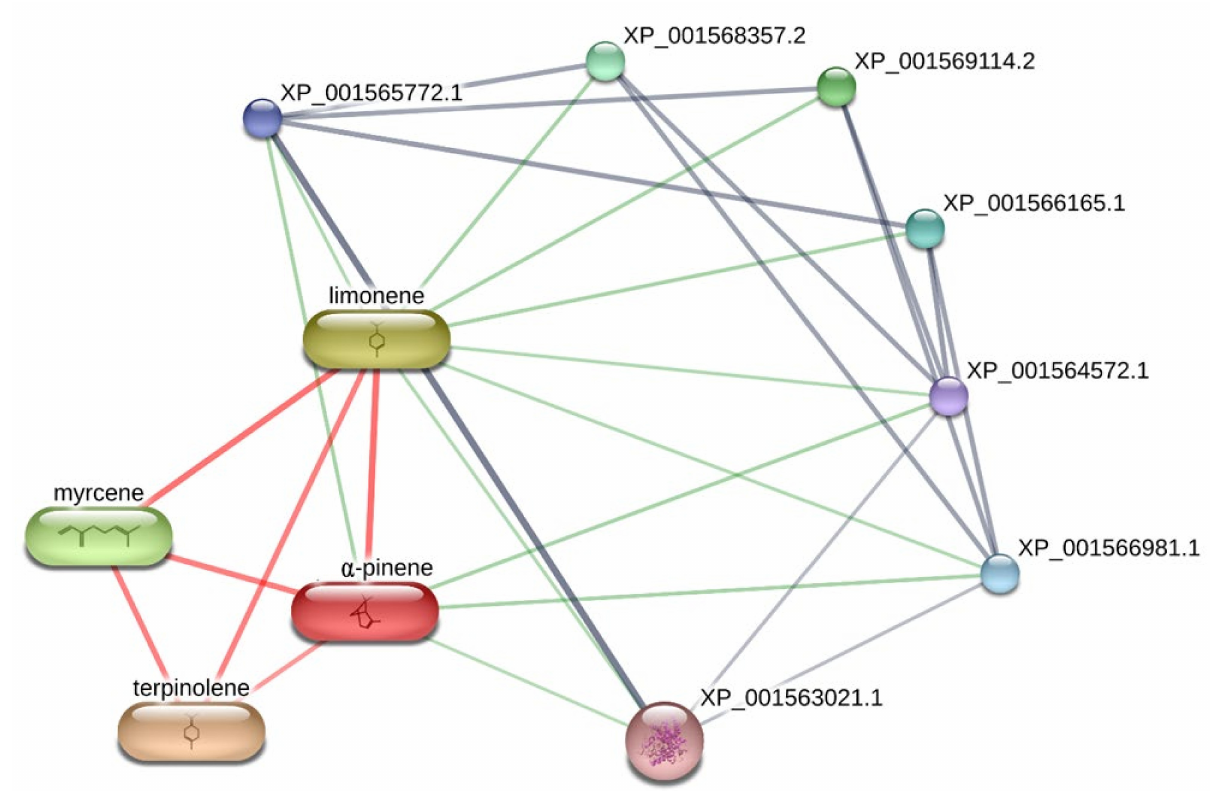
Figure 6. Network pharmacology analysis underlying the theoretical interactions between essential oil phytochemicals, namely α -pinene, myrcene, terpinolene, limonene and leishmanial target proteins. Specifically, the bioinformatics platform showed the prominent position of lanosterol-14 α -demethylase (XP_001563021.1), in the scenario of the predicted interactions, namely with α -pinene and limonene. With the only exclusion of XP_001569114.2 (methionine synthase reductase), the other predicted proteins are cytochrome p450-like